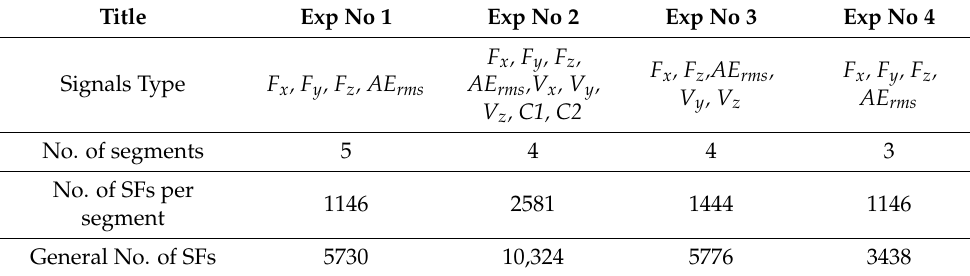
Table 3. General number of SFs for particular